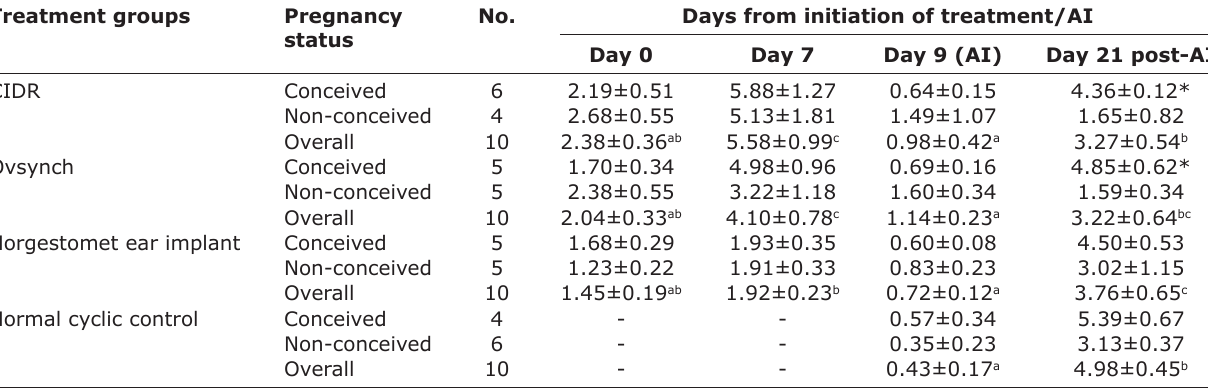
Table-2: Plasma progesterone concentrations (ng/ml) in normal cyclic and anestrus cows on different days of treatment/ AI under various estrus induction protocols. Treatment groups